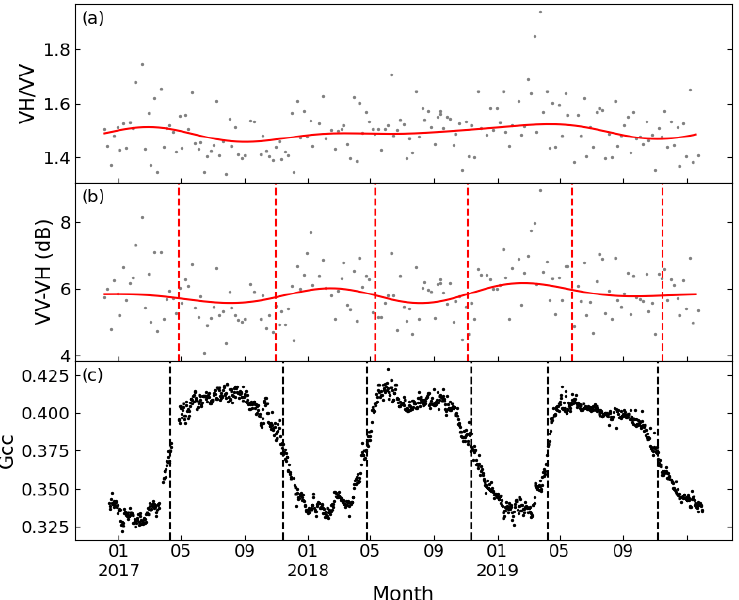
Figure 6. Seasonal patterns of Sentinel-1 for a typical coniferous forest (D02.BLAN) between 2017 and 2019. ( a ): VH/VV processed by FT (cannot detect any phenological metrics); ( b ): VV-VH processed by FT; and ( c ): Gcc. Red lines: FT function; and dashed line: phenological metrics.